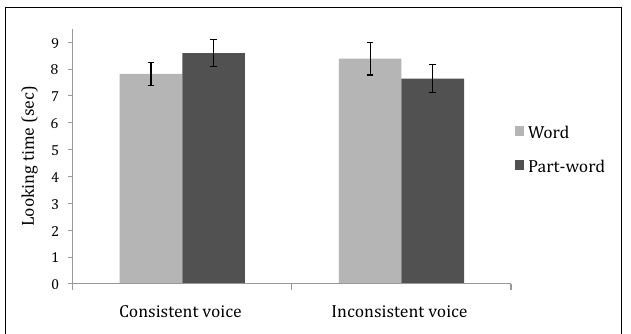
FIGURE 1 | Mean looking time (in seconds) to word versus part-word test trials. Error bars represent standard